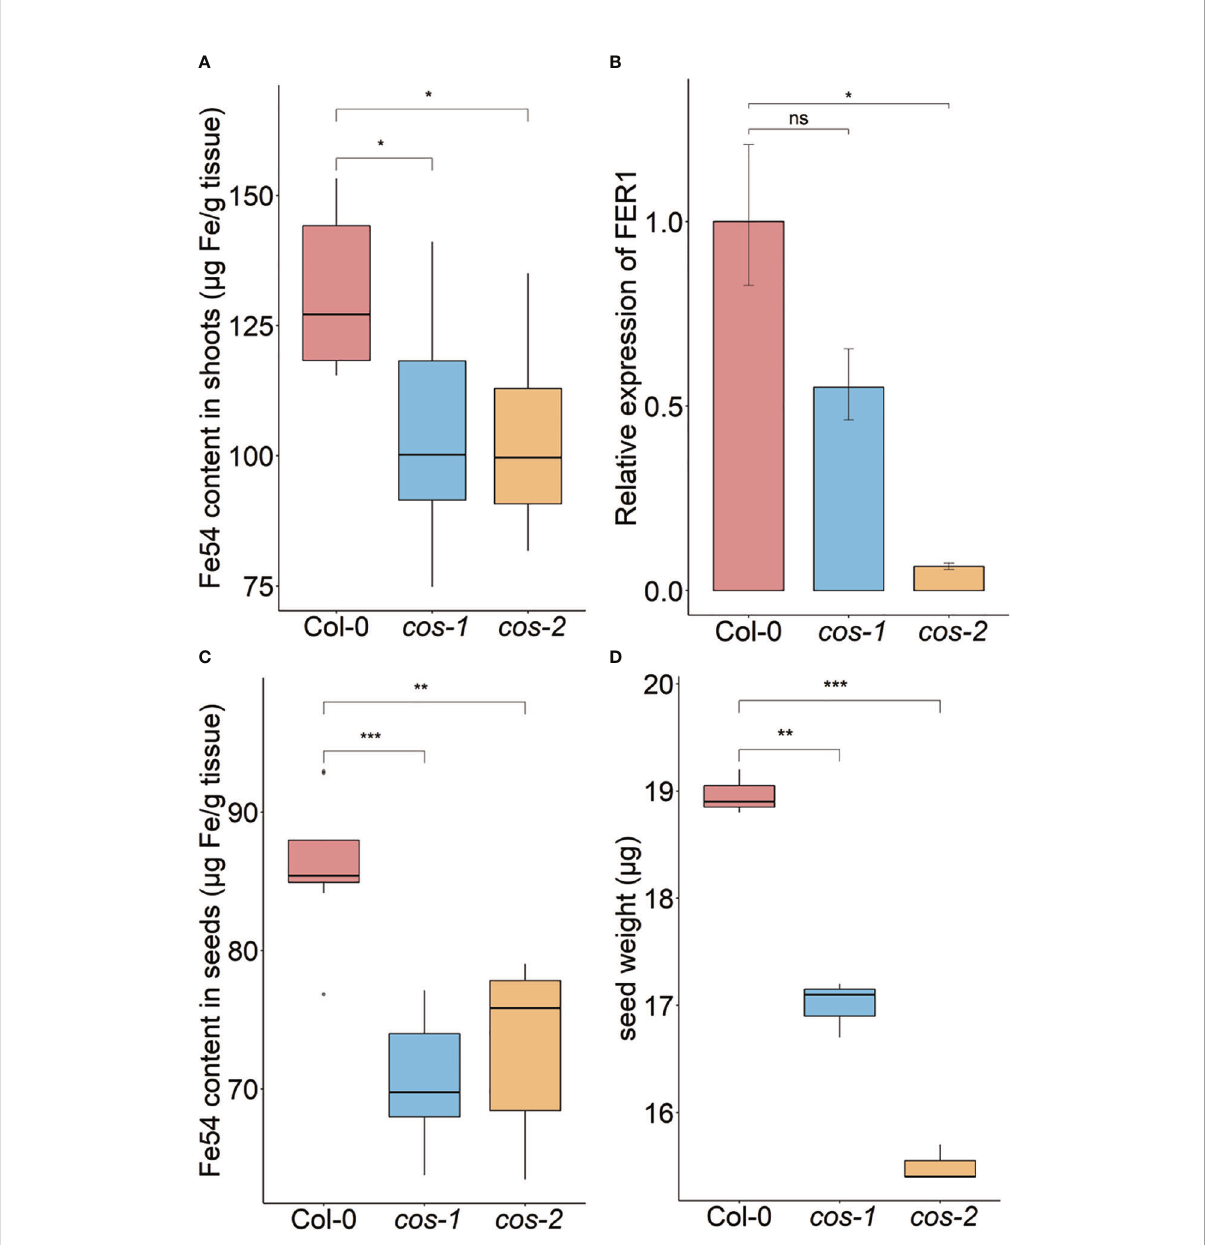
FIGURE 3 Phenotype of cos T-DNA mutants on soil. Iron concentration of shoots (A) and seeds (C) from plants grown on commercial potting mix. Results are given as m g Fe per gram of tissue (n = 8). (B) Expression levels of FER1 transcript in WT (Col-0) and cos mutants. Seedlings were grown on 1/ 2X MS agar with 50 m M Fe-EDTA for 14 d followed by a growth period of 3 d either on Fe-suf fi cient or Fe-de fi cient MS agar medium. Bars represent means ± SD of relative transcript levels normalized to ACT2 (n = 3). (D) Individual seed weight of WT and cos mutants was determined by sampling weights of 10 batches of 100 seeds. * represents p-value ≤ 0.01. ** represents p-value ≤ 0.001, *** represents p-value ≤ 0.0001, ns, not signi fi